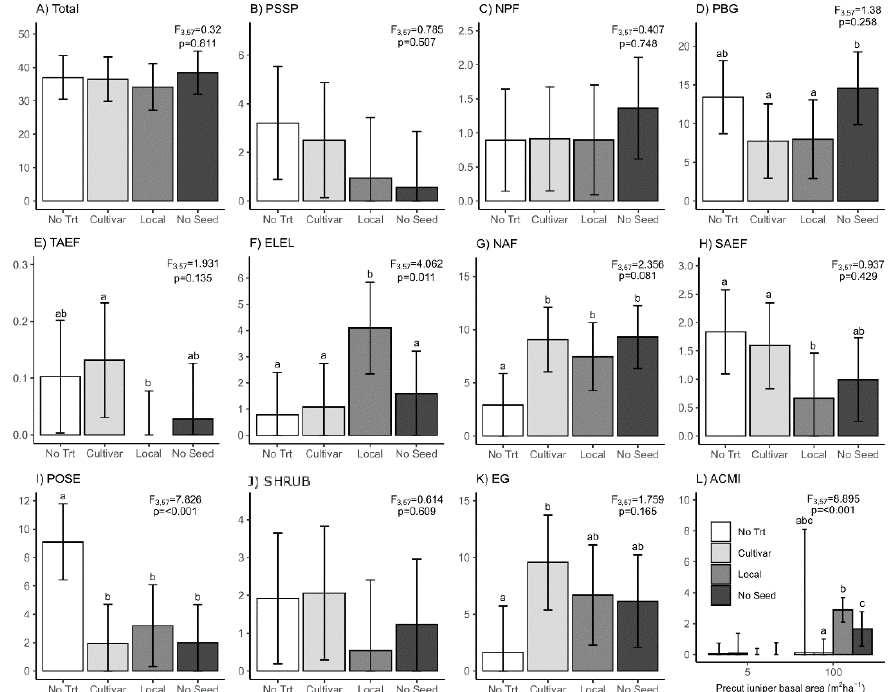
Figure 6. Functional group mean cover (%) by seeding treatment in 2017 for the skid trail experiment: least square means, 95% confidence intervals and ANOVA p -values. Lowercase letters denote significance among treatments (post-hoc contrasts, p < 0.10). The ACMI response variable had a significant interaction with precut juniper basal area, as shown in Panel L. ( A ) Total, Total plant cover; ( B ) SSP, Psuedoroegneria spicata ; ( C ) NPF, Perennial Forbs; ( D ) , Perennial large bunchgrasses; ( E ) TAEF, Tall annual exotic forbs; ( F ) ELEL, Elymus elymoides ; ( G ) NAF, Native annuals; ( H ) SAEF, Small annual exotic forbs; ( I ) POSE, Shallow, early season grass; ( J ) SHRUB, Shrubs; ( K ) EG, Exotic grasses; ( L ) ACMI, Achillea